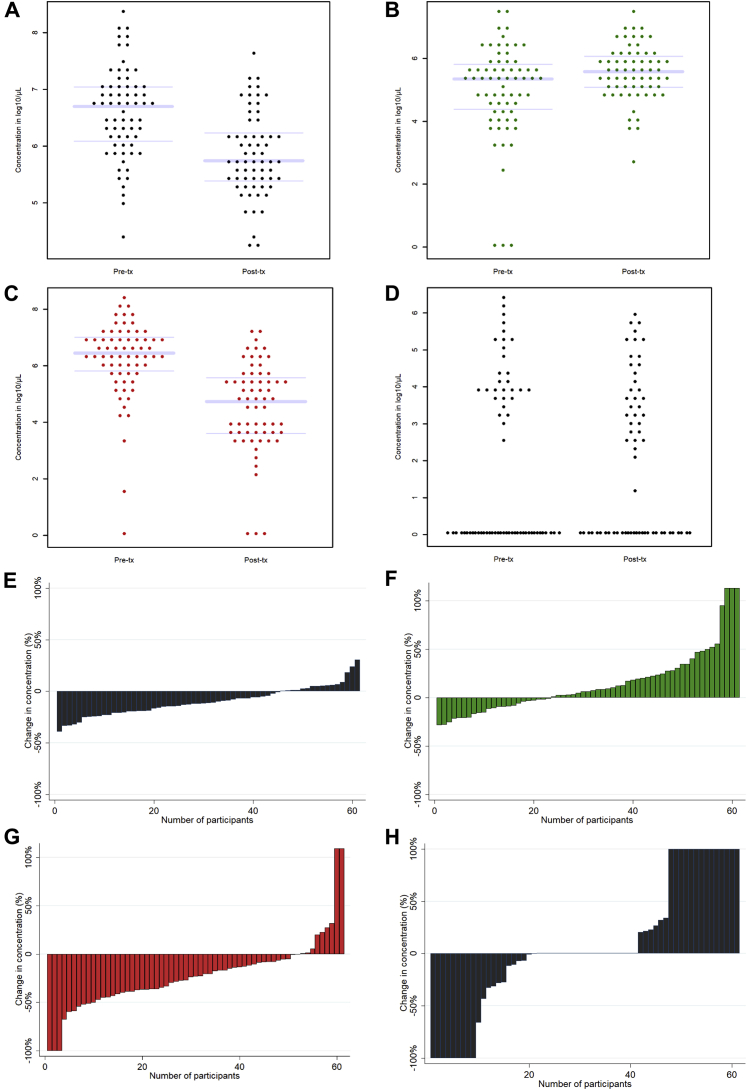
Individual bacterial group concentrations pre- and posttreatmentA-D, Changes in total bacterial concentrations and bacterial group concentrations before (n=66) and after metronidazole treatment (n=63). A, Total bacterial concentration, B, total lactobacilli, C, total BV-anaerobes, and D, total pathobionts (boxplot not shown because of high proportion of zero values). See Table 2 for mean concentrations and 95% confidence intervals, and statistical significance. E-H, Change in concentrations between pre- and posttreatment, expressed as a percentage for every individual participant with valid quantitative polymerase chain reaction results at both visits (n=61), for total bacterial concentration (E), total Lactobacillus (F), total BV-anaerobes (G), and total pathobionts (H). In some women, concentration went from zero to non-zero; these increases were set at 100% or the greatest increase observed among the other participants, whichever was greatest.BV, bacterial vaginosis; conc, concentration; Post-tx, posttreatment visit; Pre-tx, pretreatment visit.Verwijs et al. Impact of oral metronidazole treatment on the vaginal microbiota and correlates of treatment failure. Am J Obstet Gynecol 2020.